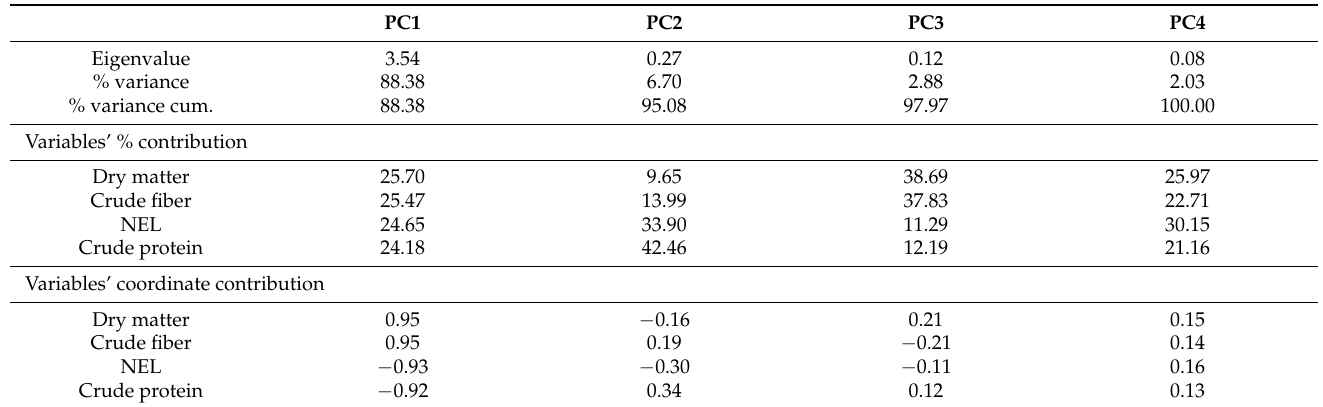
Table 3. Results of the Principal Component Analysis for the feed composition.